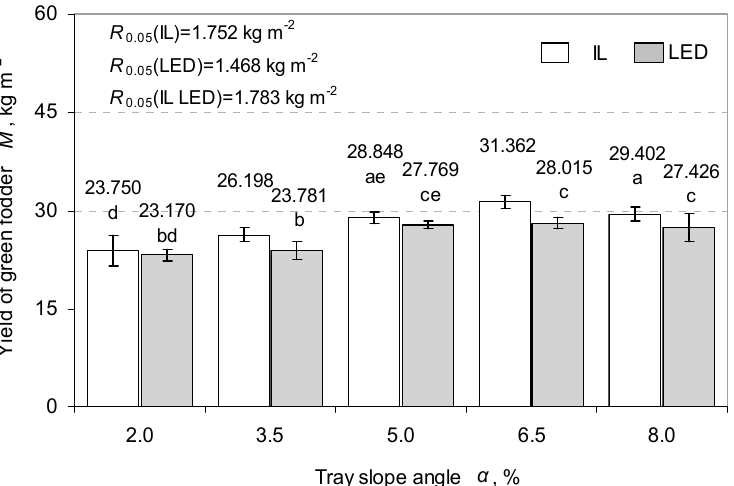
Figure 2. The yield of green fodder ( M ) after seven days of cultivation using different growing tray slope angles ( α ) and illuminations (indoor lighting (IL) or LED). Each vertical bar is 95% confidence interval. Any two samples with a common letter are not significantly different ( p < 0.05), as assessed using the least significant difference.